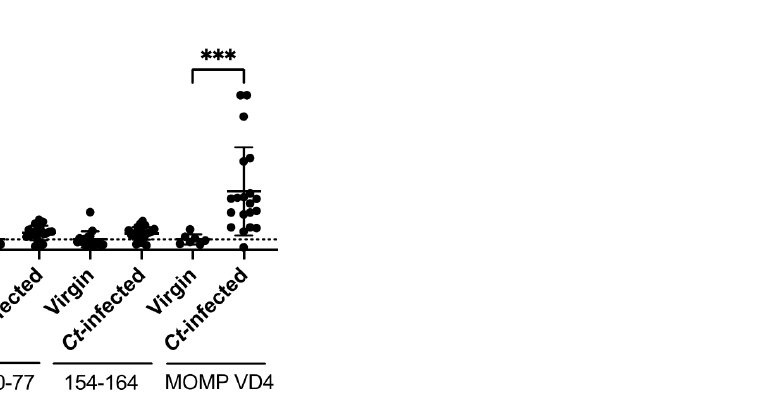
Figure 2. Urogenital tract infection with C. trachomatis in women does not elicit robust antibody re- sponses to Q β -CT584 vaccine epitopes. Virgin and C. trachomatis ( Ct )-infected women were evaluated for serum IgG to CT584 epitopes 70-77 and 154-164, as well as to the immunodominant C. trachomatis epitope MOMP VD4. Genital tract infection with C. trachomatis resulted in an average 5.45 fold increase in MOMP VD4 titers (*** p < 0.001, data adapted from [12]) compared to an average 1.58 fold and 1.56 fold increase to CT584 epitopes 70–77 and 154–164, respectively.